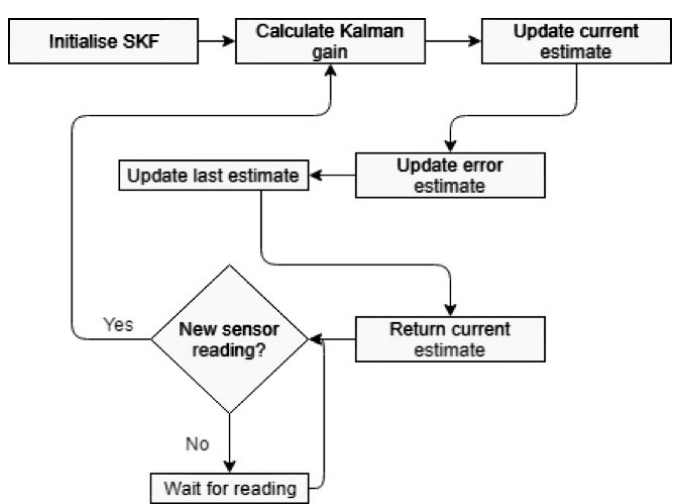
Figure 3. Scalar Kalman filter